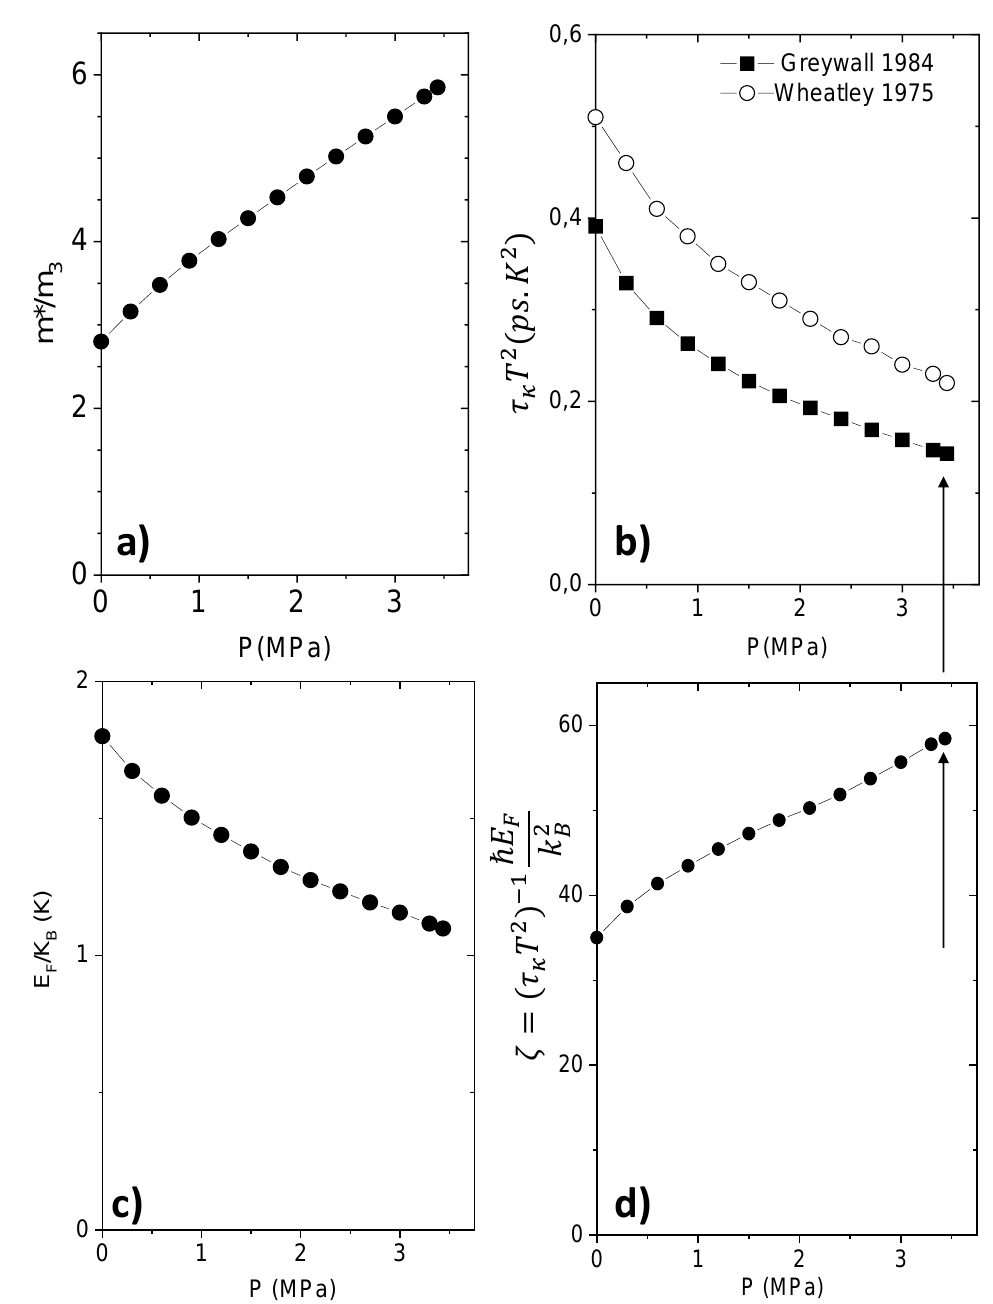
Figure 3: The case of normal liquid 3 He : a) The pressure dependence of the effective mass in 3 He quantified by measuring the T-linear specific heat [ 12 ] . b) The quasi-particle scattering time extracted from thermal conductivity multiplied by T 2 as a function of pressure, according to Wheatley [ 11 ] and Greywall [ 13 ] . c) The pressure dependence of the Fermi energy using the Fermi momentum and the Fermi velocity given by Greywall [ 13 ] . d) The pressure dependence of the inverse of the normalised quasiparticle lifetime using Greywall’s data (see text). Black arrows show the pressure at which solidification